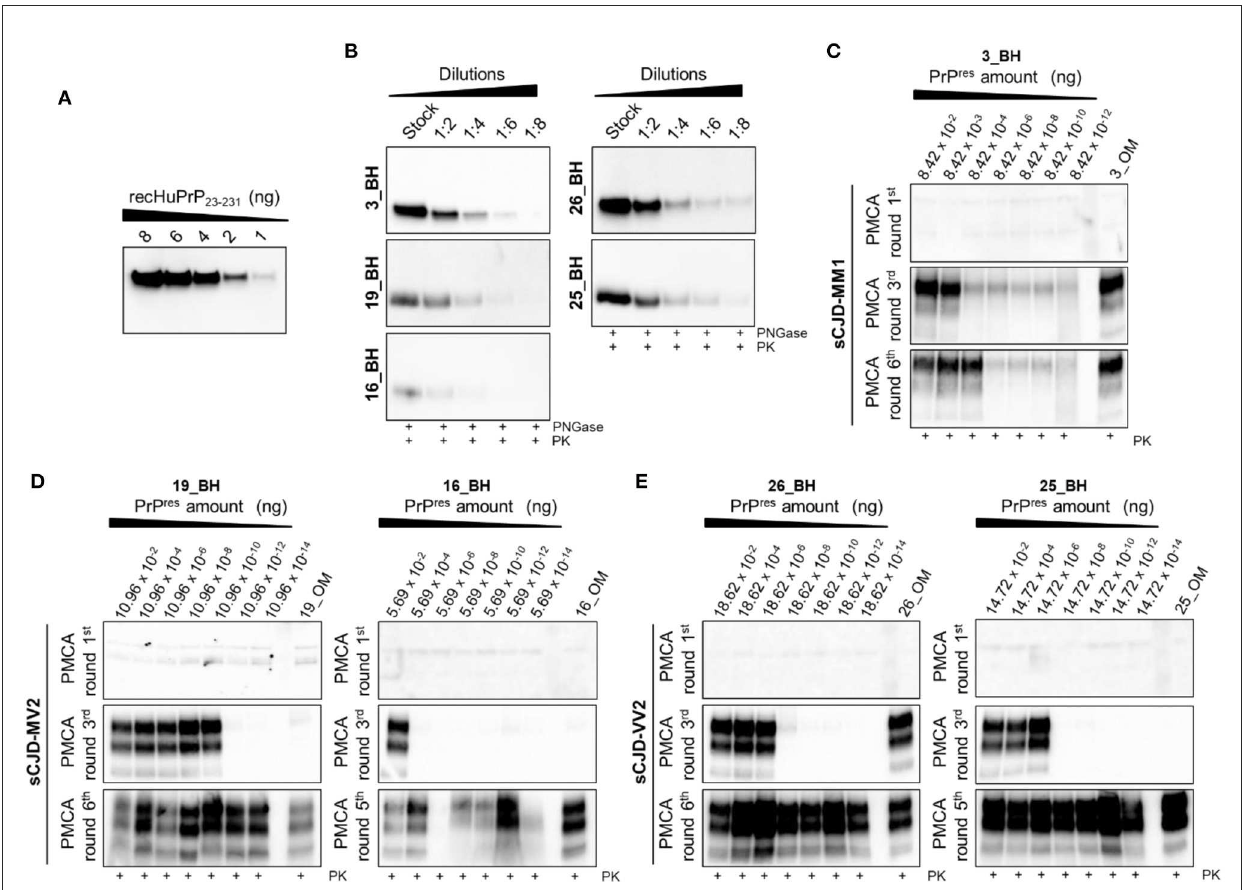
FIGURE5 Quantitative PMCA (qPMCA) for estimating PrP res concentration in OM samples of sCJD patients. (A) Serial dilutions of recombinant full-length human PrP (recHuPrP 23 − 231 ) were used to estimate prion concentration in the brain of sCJD patients. (B) Serial dilutions of sCJD brain homogenates subjected to PK and PNGase treatments before Wb analysis. Quantitative PMCA to estimate PrP res concentration in OM of (C) MM1, (D) MV2, and (E) VV2 patients. Specific rounds at which every OM PrP res was detected (3 rd for the MM1 and one VV2, 5 th for one MV2 and one VV2, and 6 th for one MV2) are